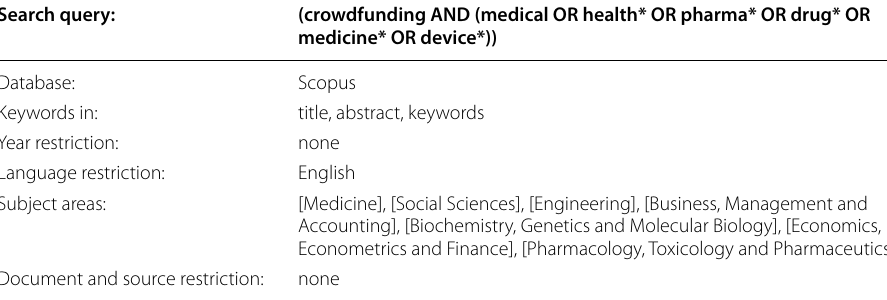
Table 1 Literature review database